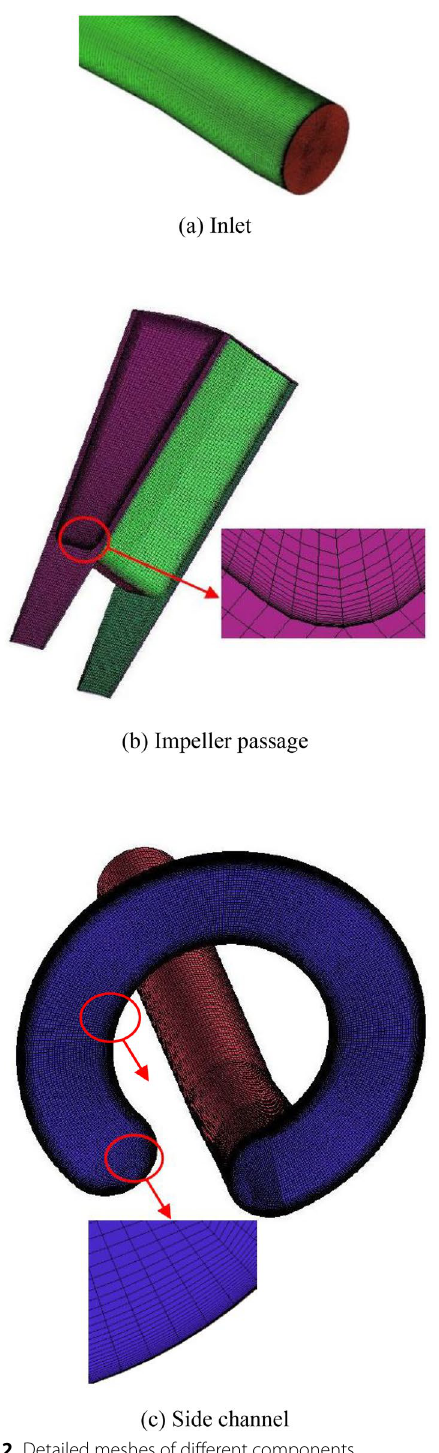
Figure 2 Detailed meshes of different components